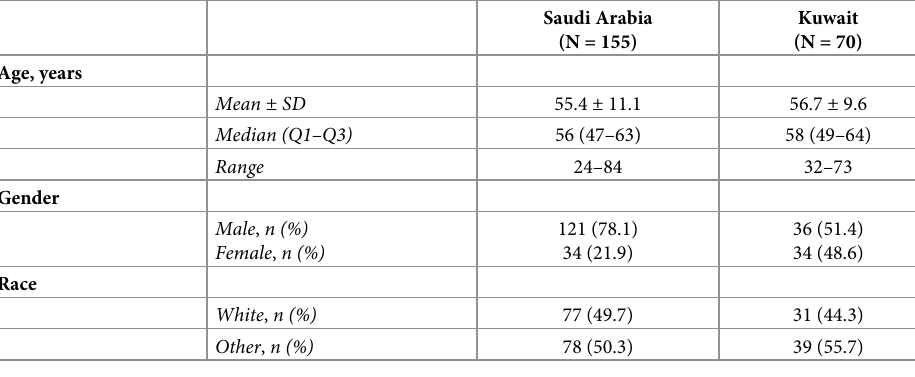
Table 1. Patient demographics in Saudi Arabia and